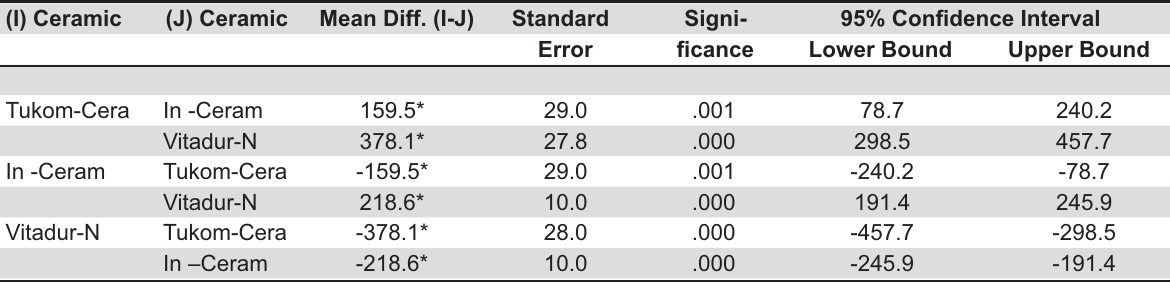
Table 2- Multiple comparisons between the three all-ceramic systems